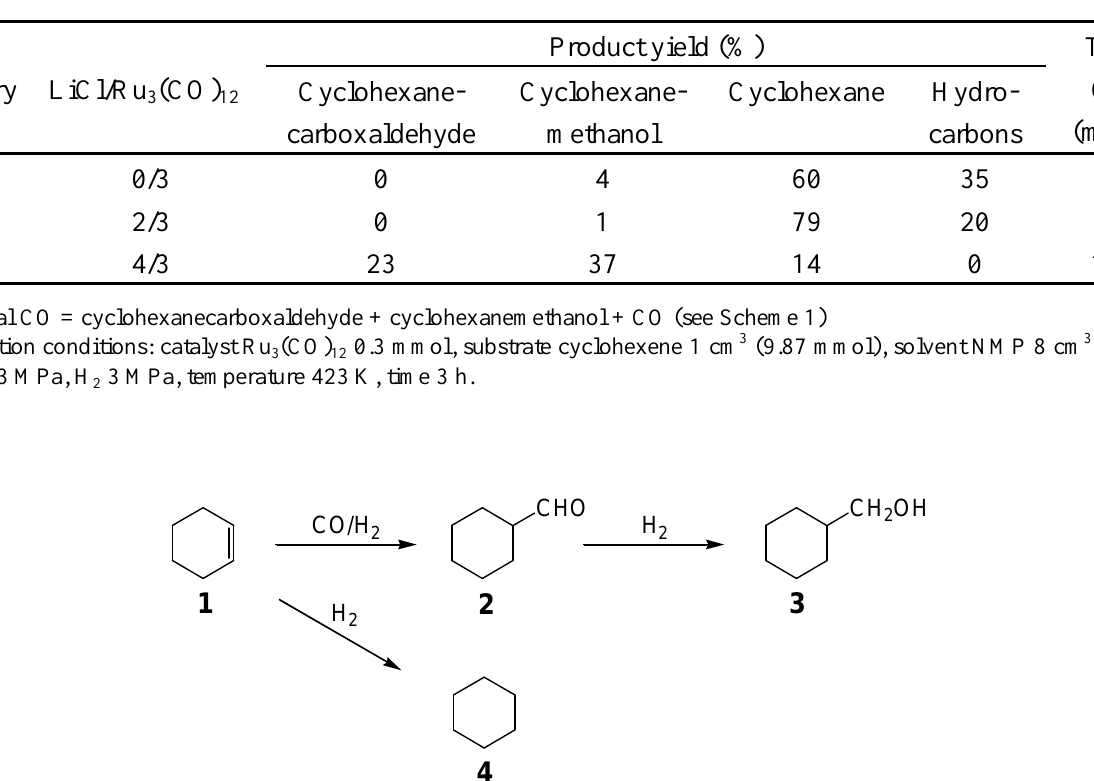
Table 1. Influence of the amount of LiCl additive used on the reactions of cyclohexene